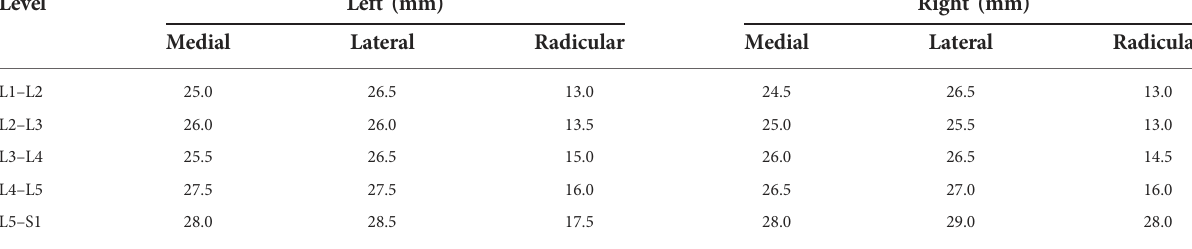
TABLE 2 Measurements of the MVL length with regard to the spine